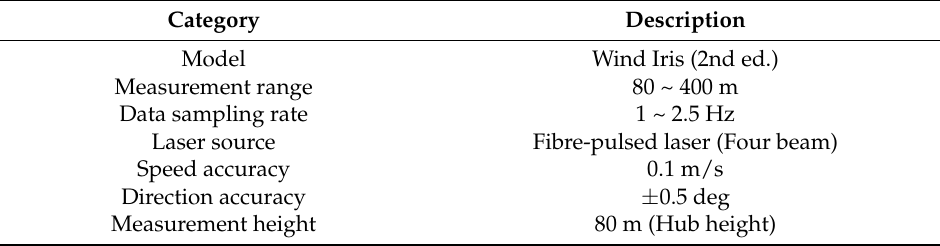
Table 4. Specification of the nacelle LIDAR.